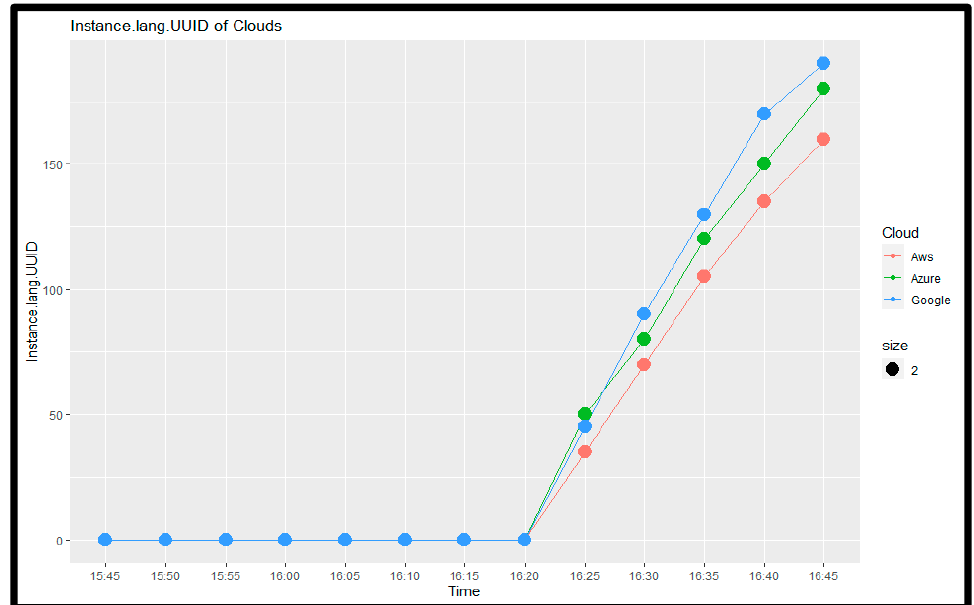
Figure 7. Instance Lang. UUID of clouds.